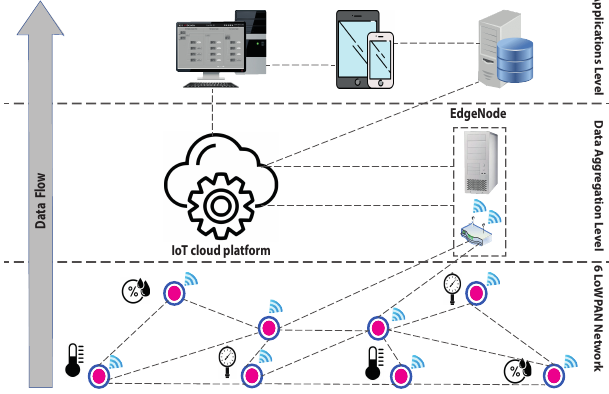
Figure 2. Architecture of considered IoT 6LoWPAN